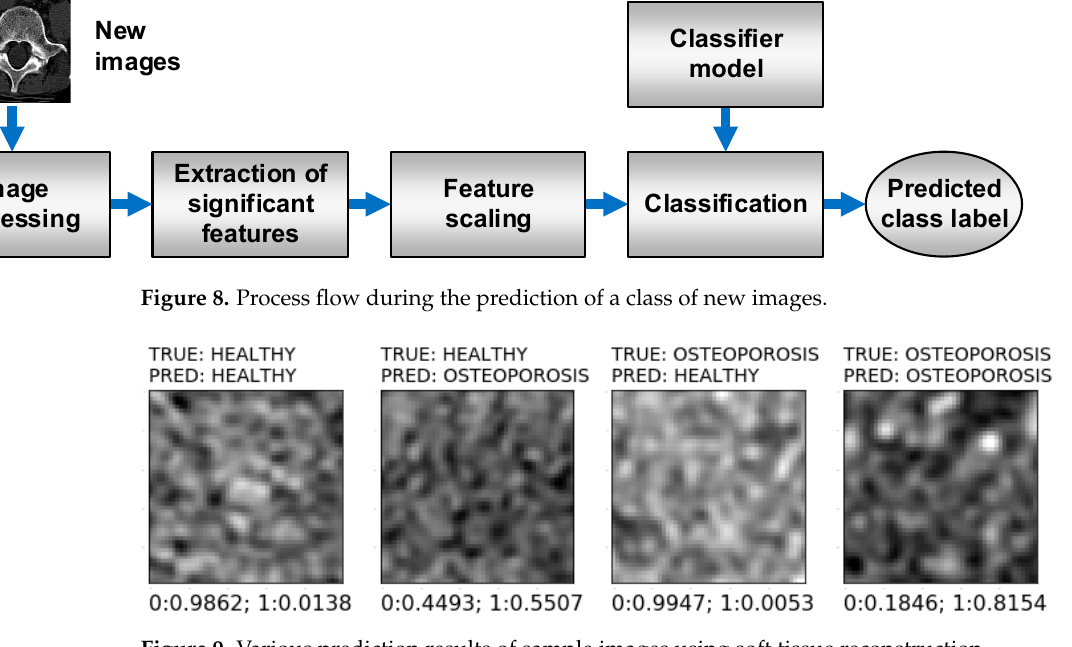
Figure 9. Various prediction results of sample images using soft tissue reconstruction.